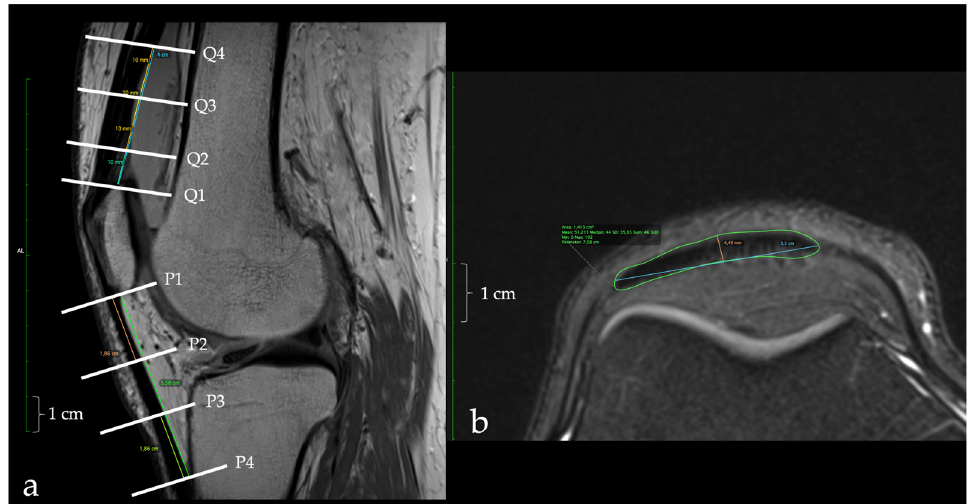
Figure 1. ( a , b ) MRI evaluation of the dimensions of the patellar and the quadriceps tendons. All measurements were performed at a level perpendicular to the respective tendon ( a ). The measurements in the quadriceps tendon were performed at the patellar attachment of the tendon and at 3 sites proximally with a 1-cm distance between them (Q1-Q4). In the patellar tendon, 4 measurements were performed at the proximal (P1) and the distal (P4) tendon attachment and in two positions between those measurement sites (P2 and P3). In ( b ), an example of the measurements in the axial plane is shown. The mediolateral and anteroposterior patellar tendon length, as well as the cross-sectional area of the patellar tendon are shown.